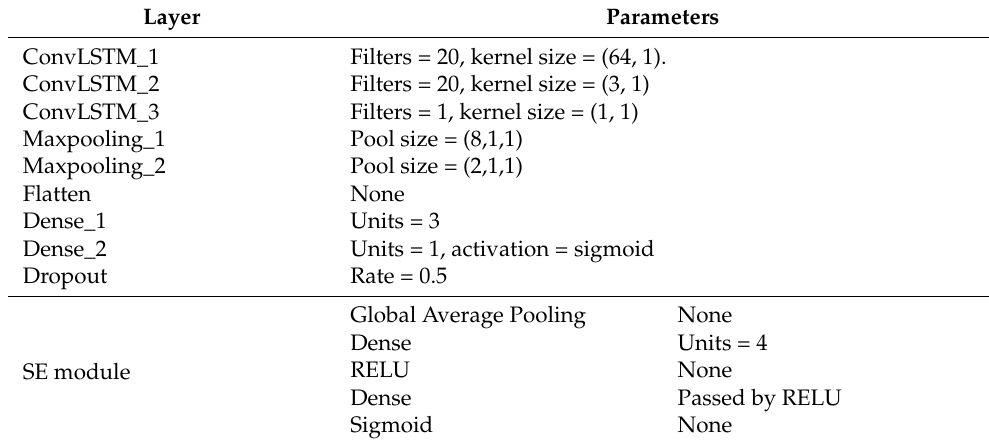
Table 1. Parameter configuration of the proposed network.